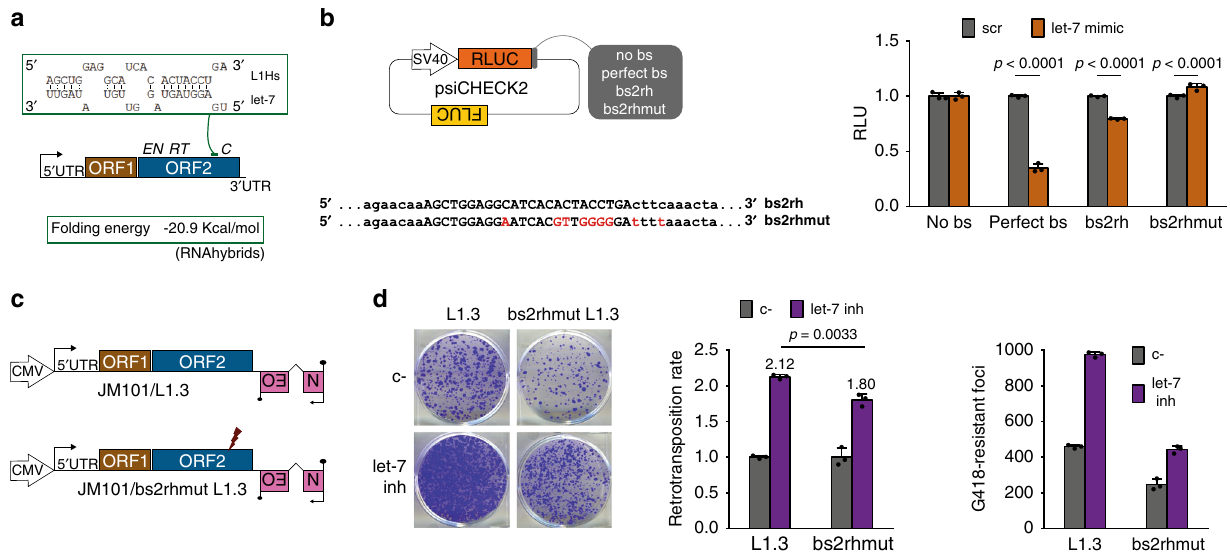
Fig. 4 L1 mRNA contains a functional let-7 binding site located in L1-ORF2. a RNAhybrid prediction of the best binding site for let-7 located in the region of L1Hs identi fi ed as “ bs2 ” with RNA22. Base-pairing between this region and let-7b is shown (green rectangle). Localization of the putative binding site ( “ bs2rh ” ) within L1 sequence is shown (green line). Structure of LINE-1 is shown: transcription start site (black arrow), 5 ′ untranslated region (UTR), ORF1, ORF2 with its three domains endonuclease (EN), reverse transcriptase (RT), and cysteine-rich (C), and 3 ′ UTR. Folding energy of the predicted binding site is shown below. b psiCHECK2 assay with “ bsrh ” and “ bs2rhmut ” . Left panel: scheme of psiCHECK2 plasmid containing SV40 promoter, Renilla luciferase gene (RLuc, orange rectangle), different sequences cloned in the 3 ′ UTR of the RLuc gene (gray rectangle), and Fire fl y luciferase gene (FLuc, brown rectangle). Comparison of the sequences cloned in psiCHECK2 as “ bs2rh ” and “ bs2rhmut ” is shown below, with the nucleotides interacting with let-7 in capital letters and the different nucleotides highlighted in red. Right panel: HEK293T cells were co-transfected with the different psiCHECK2 constructs and scr or let-7 mimic. Data are presented as mean values ± s.d. of three replicates. Source data are provided as a Source Data fi le. RLU: Relative Luminescence Units. Statistically signi fi cant exact p values are shown after applying an unpaired two-tailed t test. c Scheme of the wild type L1.3 and the binding site mutant “ bs2rhmut L1.3 ” generated by site-directed mutagenesis. Red thunder indicates location of the mutated binding site. d HeLa cells were co- transfected with JM101/L1.3 or JM101/bs2rhmut L1.3 and let-7 inhibitor or its control (c-). A representative well of three replicates is shown. Quanti fi cation is shown as retrotransposition rate (relative to c-) and raw colony count, in both cases as average of three replicates ± s.d. Source data are provided as a Source Data fi le. Statistically signi fi cant exact p values are shown after applying an unpaired two-tailed t